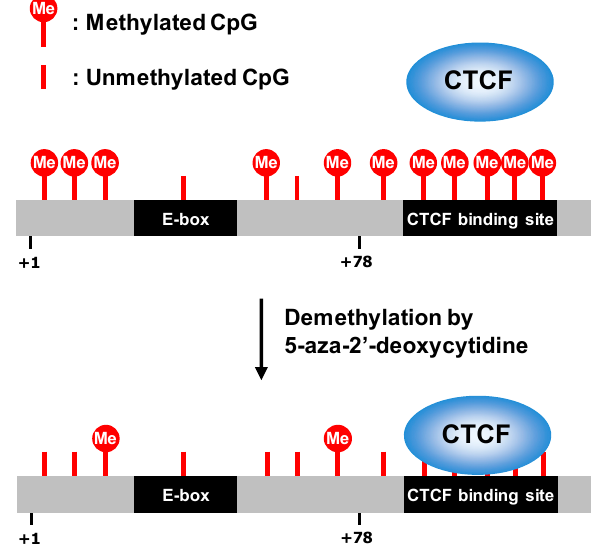
Figure 2. Regulation of hTERT transcription by 5-aza-2 ′ -deoxycytidine. In cancer cells, CTCF recognition sequence in hTERT gene is hypermethylated, thus blocking CTCF binding and inducing hTERT expression. Treatment with 5-aza-2 ′ -deoxycytidine leads to demethylation of hTERT promoter, thereby causing the binding of CTCF to the target site and suppressing hTERT transcription.